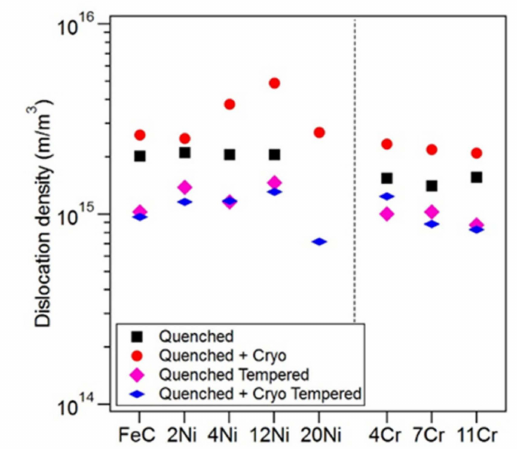
Figure 8. Dislocation density of the model alloys before and after tempering, which was measured using XRD. The cryogenic treatment for these specimens was 24 h. The fitting error is approximately the same size as the data points.